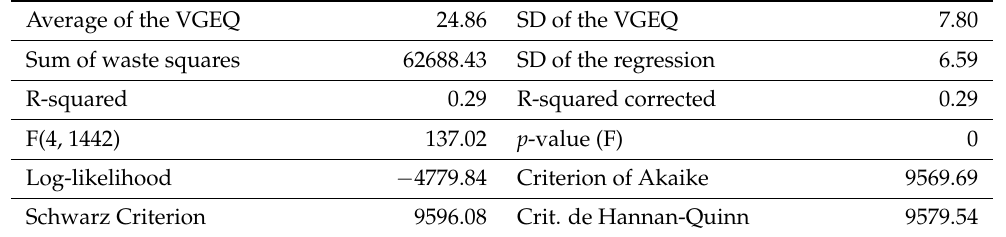
Table 4. Linear regression